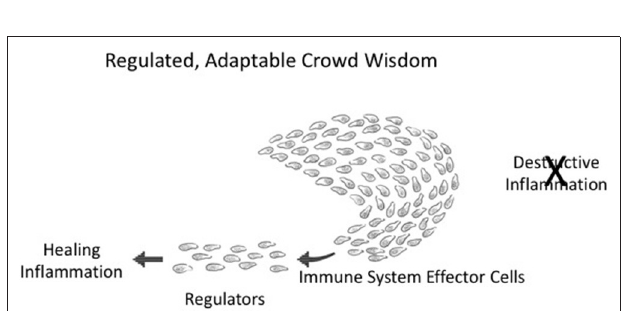
FIGURE 4 | Adaptable crowd wisdom. A swarm of immune cells is depicted as a school of fish initially proceeding in the direction of Destructive Inflammation ; but a small number of Regulators (by spreading Co-respondence; see Figure 3 ) can shift the behavior of the entire swarm toward Healing